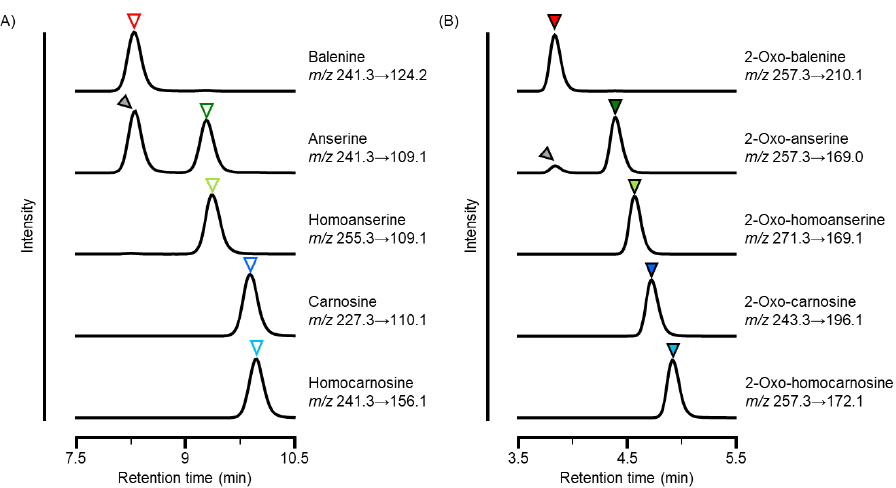
Figure 4. Separation of several IDPs and 2-oxo-IDPs using HPLC-ESI-MS/MS. A standard mixture of IDPs and 2-oxo-IDPs (1 µ M each) was subjected to HPLC-ESI-MS/MS using an Intrada Amino Acid column. ( A ) Representative MS/MS chromatograms of IDPs. Open triangles indicate each IDP, and the gray triangle indicates balenine detected in MRM for anserine. ( B ) Representative MS/MS chromatograms of 2-oxo-IDPs. Filled triangles indicate each 2-oxo-IDP, and gray triangle indicates 2-oxo-balenine detected in MRM for 2-oxo-anserine. Table 3. LOD and LOQ of IDPs and